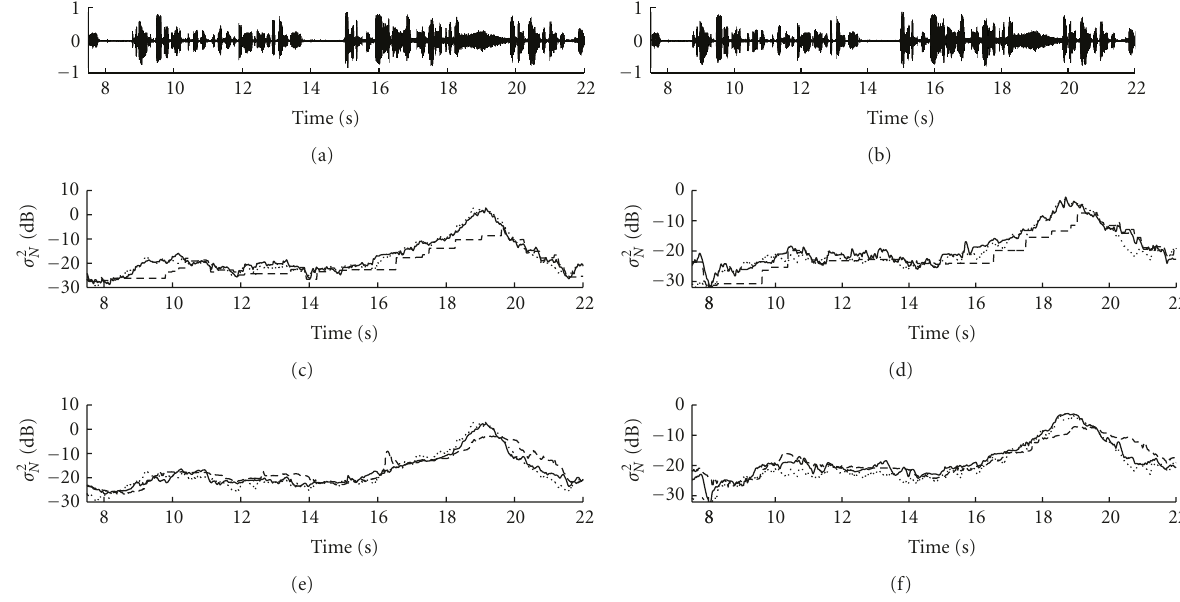
Figure 7: Comparison between estimated noise PSD and the true noise PSD. (a)-(b) Speech signal degraded by noise originating from passing cars at an overall SNR of 10 dB. (c)-(d) Comparison between true noise PSD (dotted line), proposed approach (solid line), and MS (dashed line) for DFT bin centered around (c) 0.9kHz and (d) 2.0 kHz. (e)-(f) Comparison between true noise PSD (dotted line), DFT-subspace approach (solid line), and QB approach (dashed line) for DFT bin centered around (e) 0.9 kHz and (f) 2.0